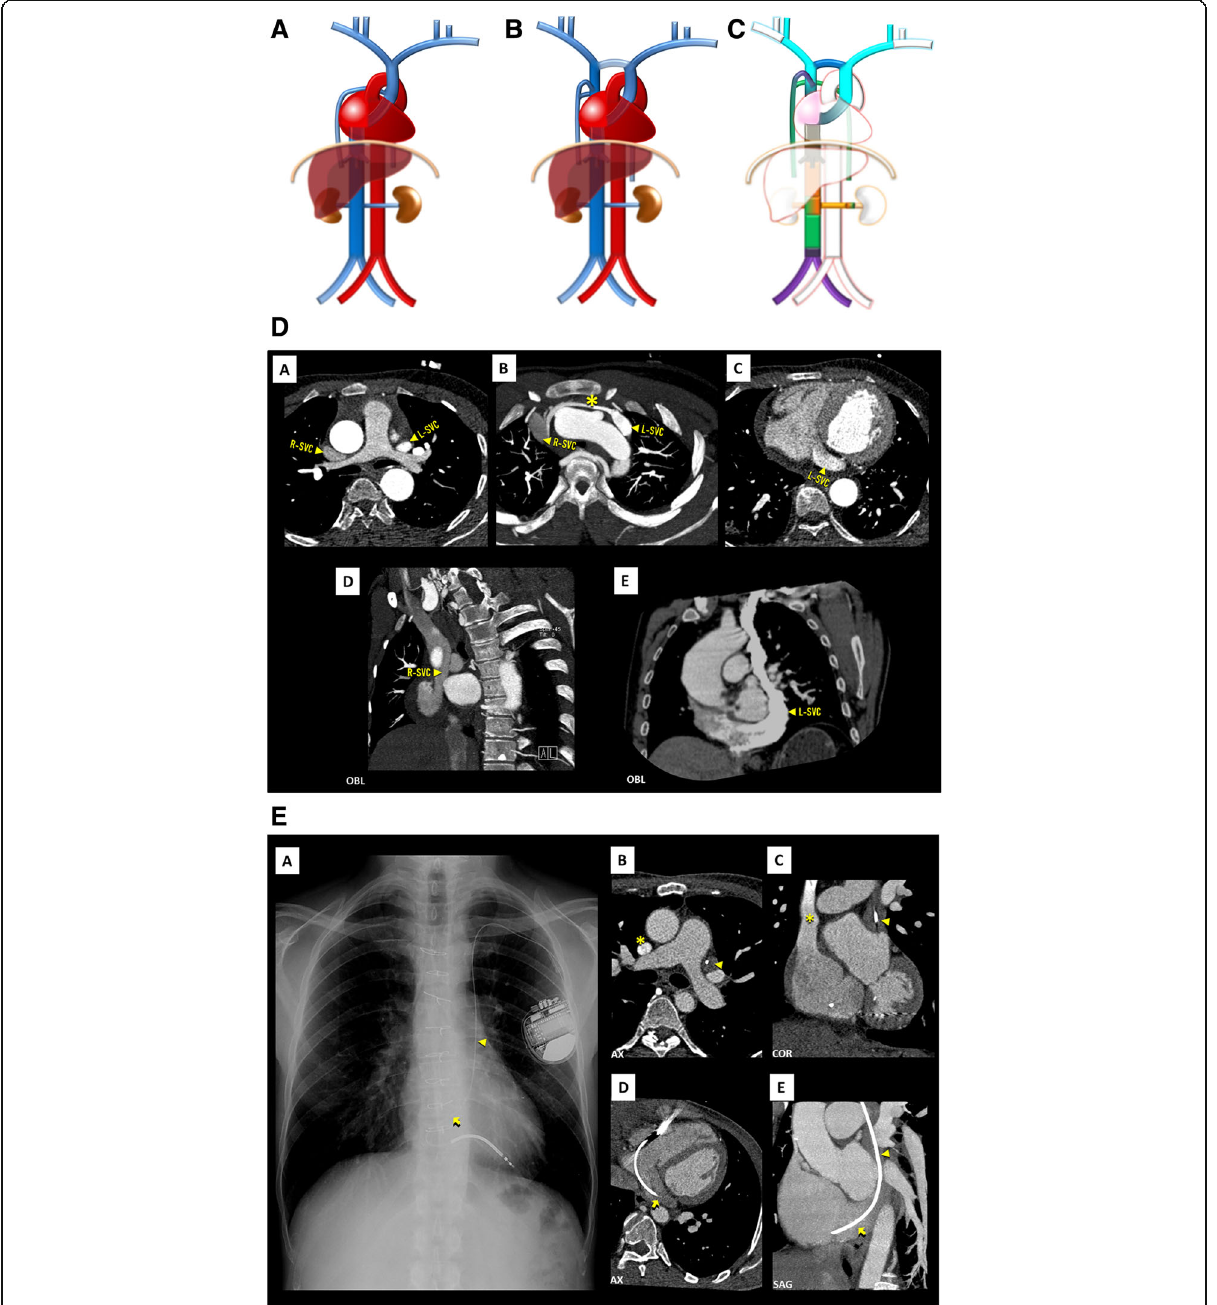
Fig. 3 a Left SVC schematic. A single left SVC, with its usual course lateral to the aortic arch and drainage into the coronary sinus. b Double SVC schematic. The most frequent case of left SVC persistence, in which there are two SVC, each running on one side of the mediastinum, the right draining normally and the left one draining typically to the coronary sinus. These may or, more frequently, may not be connected by the left brachiocephalic vein. c Double SVC embryology schematic. Double SVC resulting from the persistence of the left anterior cardinal vein, here connected by the inter- anterior cardinal anastomosis (dark blue), precursor of the left brachiocephalic vein. If, in addition, there was regression of the right anterior cardinal vein, the end result would be a single left SVC. d Double SVC imaging. Contrast-enhanced CT showing double SVC, with a left-sided SVC (L-SVC) along the left side of the mediastinum [A] and draining into an enlarged coronary sinus [C – E], connected to a normal right-sided SVC (R-SVC) by the left brachiocephalic vein (asterisk) [B]. e Persistent left SVC eventuated by left-sided implantable cardioverter defibrillator leads. Chest X-ray [A] and contrast-enhanced CT scan [B – D] showing persistent left SVC (triangle) eventuated by a left-sided implantable cardioverter defibrillator lead, entering the right atrium via the coronary sinus